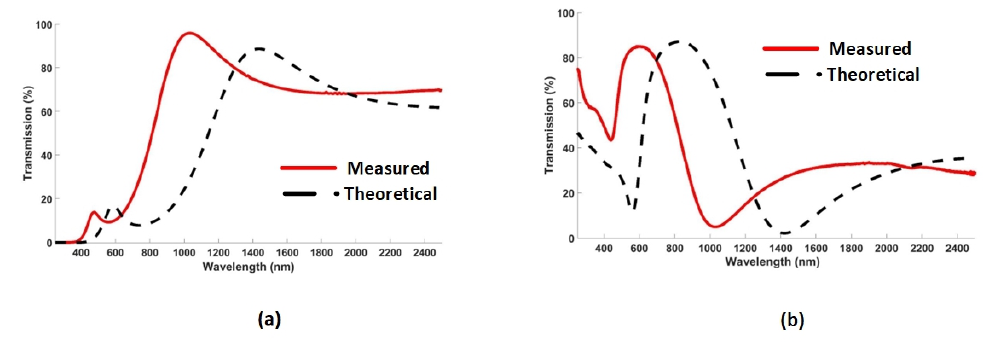
Figure 3. Theoretical (dotted line) and measured (solid line) results for ( a ) transmission and ( b ) reflection spectra of hybrid etalon with d = 40 nm and h = 100